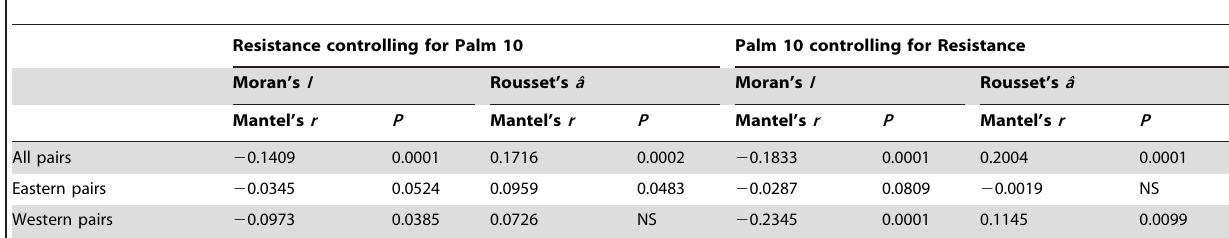
Table 3. Results of partial Mantel tests between genetic distances (Moran’s I and Rousset’s aˆ ), resistance distances (generated in CIRCUITSCAPE), and the best least-cost distances (oil palm plantations at a cost of 10,